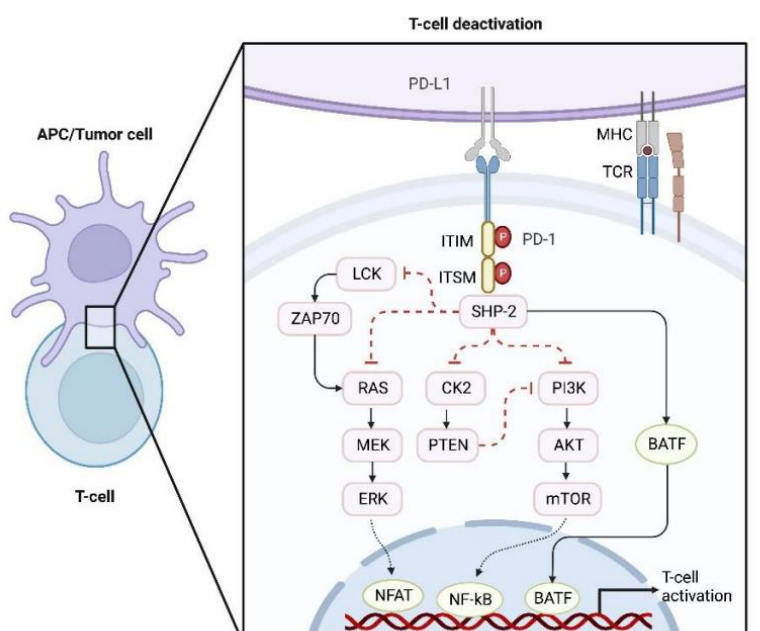
Figure 1. PD-1/PD-L1-mediated inhibition of T cell activation. The binding of PD-1 to PD-L1 recruits SHP-2, thereby weakening the TCR signaling pathway mediated by LCK and inhibiting the RAS-MEK- ERK and PI3K-Akt-mTOR pathways. In addition, PD-1 activation induces the expression of BTAF, which inhibits the expression of effectors for T cell activation. Collectively, the activation of T cells can be inhibited by PD-1/PD-L1-mediated inhibiting of these signaling pathways. Abbreviations: PD-1, programmed cell death protein 1; PD-L1, programmed cell death 1 ligand 1; TCR, T cell receptor; MHC, major histocompatibility complex; APC, antigen-presenting cell; ITIM, immunoreceptor tyrosine inhibitory motif; ITSM, immunoreceptor tyrosine-based switch motif; P, phosphorylation; LCK, lymphocyte-specific protein-tyrosine kinase; ZAP70, zeta chain of T cell receptor associated protein kinase 70; SHP-2, src homology-2 domain-containing protein tyrosine phosphatase; BATF, basic leucine zipper transcriptional factor ATF-like; RAS, rat sarcoma; MEK, mitogen-activated extracellular signal-regulated kinase; ERK, extracellular regulated protein kinase; NFAT, nuclear factor of activated T cell; CK2, casein kinase II; PTEN, phosphatase and tensin homolog; PI3K, phosphoinositide 3-kinase; AKT, protein kinase B; mTOR, mammalian target of rapamycin; NF- κB, nuclear factor kappa-B.